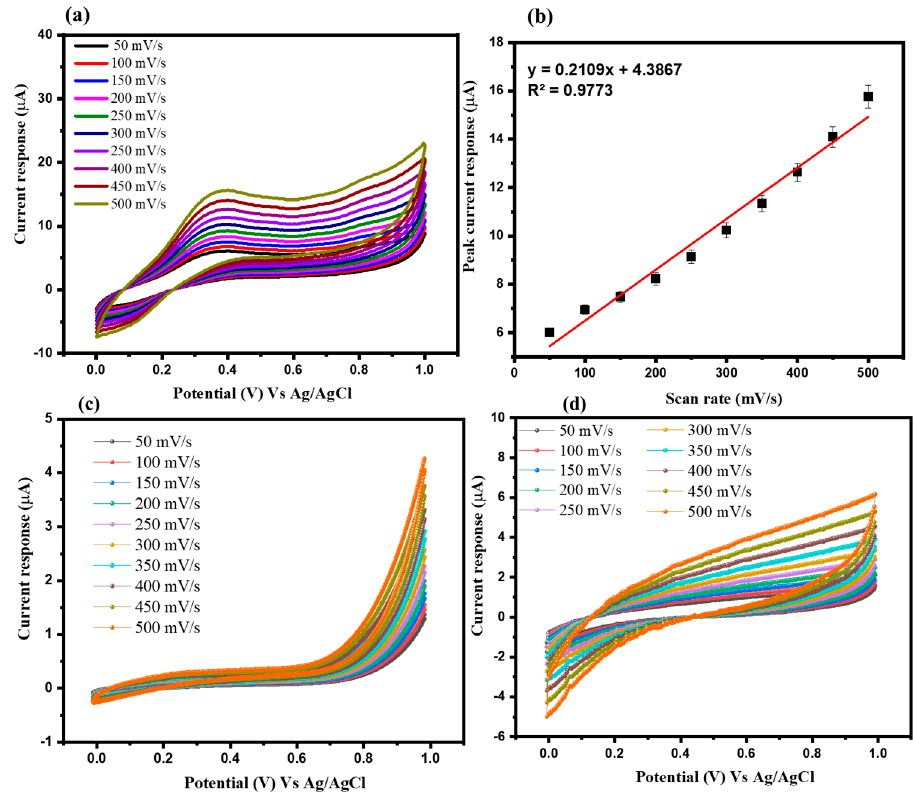
Figure 6. ( a ) CV response and ( b ) calibration plot of the NiO-GE for 5 ppb As 3+ (0.1 M PBS of pH = 6) with respect to the scan rates (50–500 mVs − 1 ). CV responses of GE ( c ) and NiO-GE ( d ) for 0 ppb As 3+ at various scan rates (50–500 mVs − 1 ).